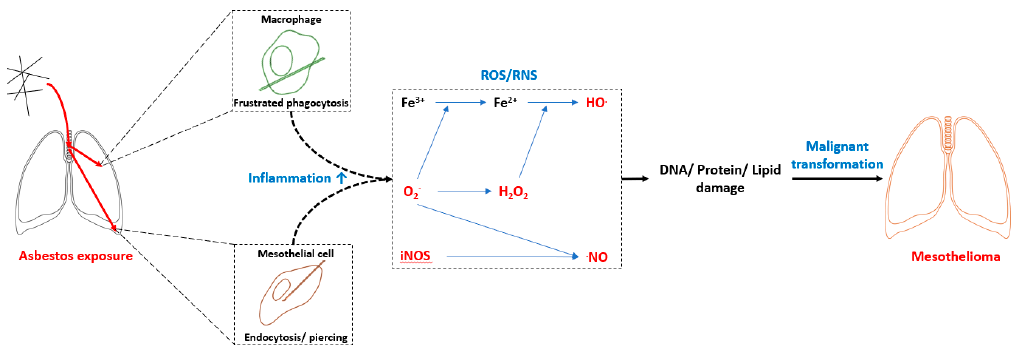
Figure 1. Asbestos induced inflammatory process. ROS—reactive oxygen species; RNS—reactive nitrogen species; iNOS—inducible nitric oxide synthase.